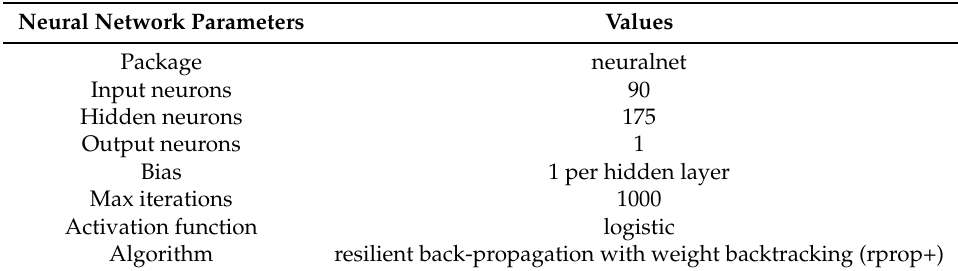
Table 4. Configuration of the neural network selected.